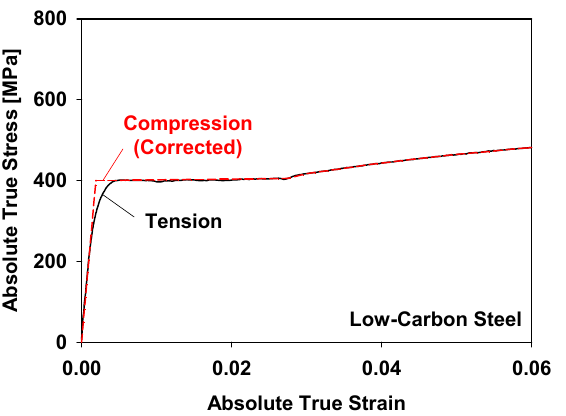
Figure 15. Corrected absolute true stress–strain curves of the low ‐ carbon steel for tension and com ‐ pression.